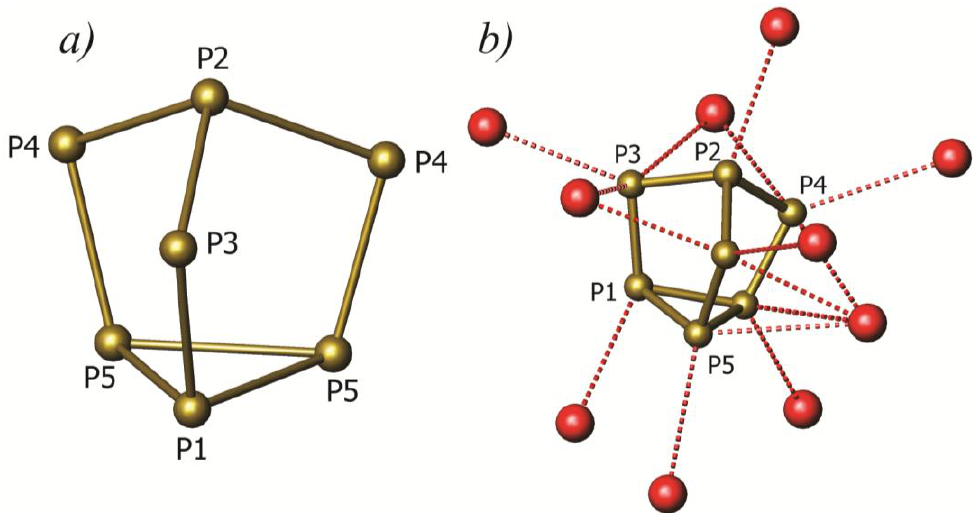
) 3− cluster and ( b ) its 7 P X (X = Cl, Br, 2 7